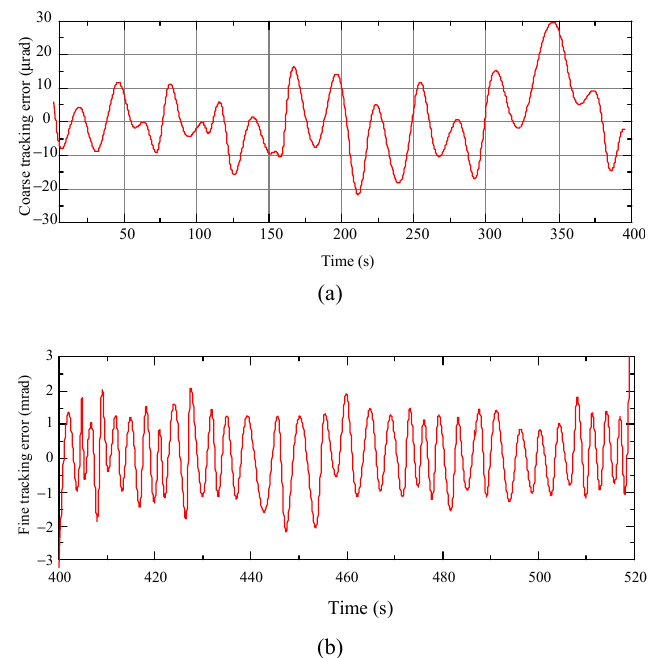
Fig. 4 Tracking precision of indoor test: (a) coarse tracking error and (b) fine tracking